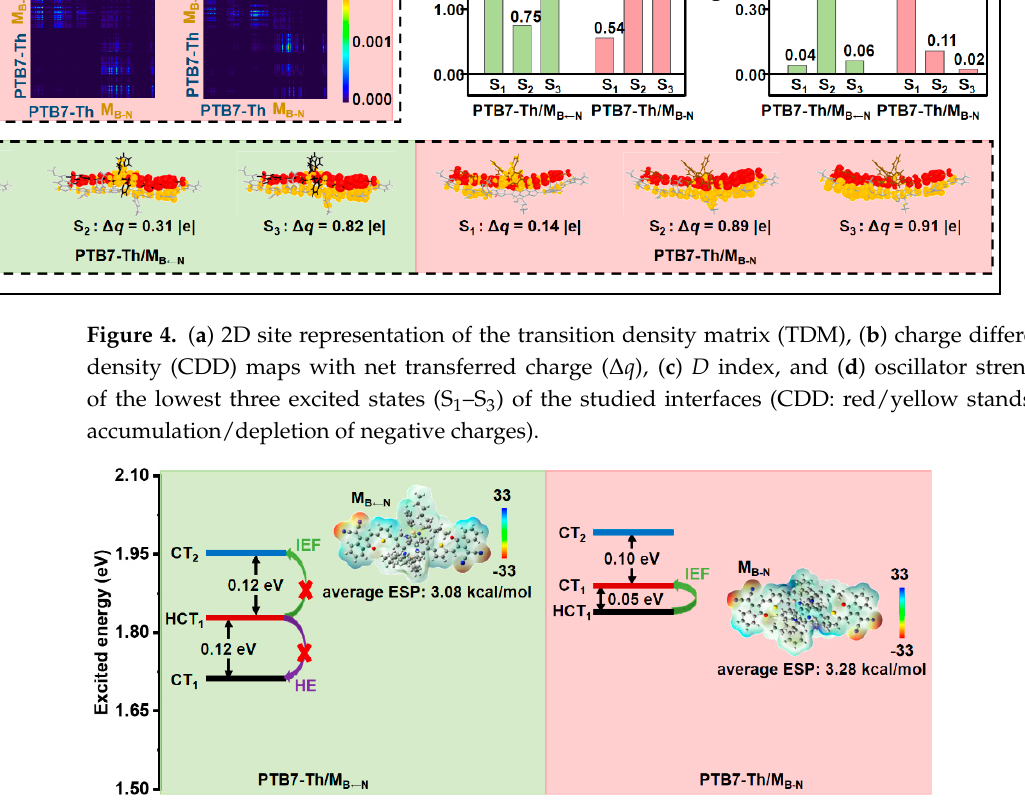
Figure 4. ( a ) 2D site representation of the transition density matrix (TDM), ( b ) charge difference density (CDD) maps with net transferred charge ( Δ q ), ( c ) D index, and ( d ) oscillator strengths of the lowest three excited states (S 1 -S 3 ) of the studied interfaces (CDD: red/yellow stands for accumulation/depletion of negative charges).